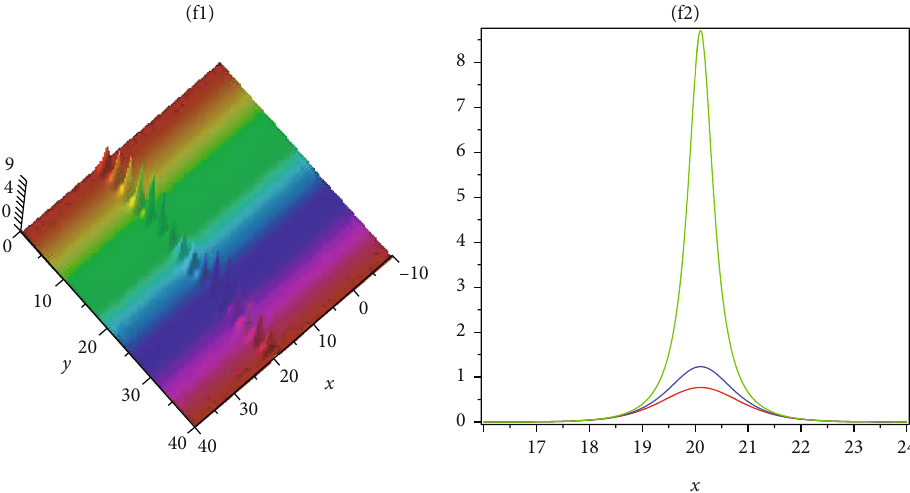
Figure 8: Graph of the absolute value of Eq. (42) for the ( 2 + 1 )-dimensional Benjamin-Ono equation at a = 2, α = 2, β = − 3, c = 2, γ = 2, r = 1, w = 0 : 3, d = 2, δ = − 2, z = 1, t = 20 and for 2 plot spaces y = − 10, − 3, 1